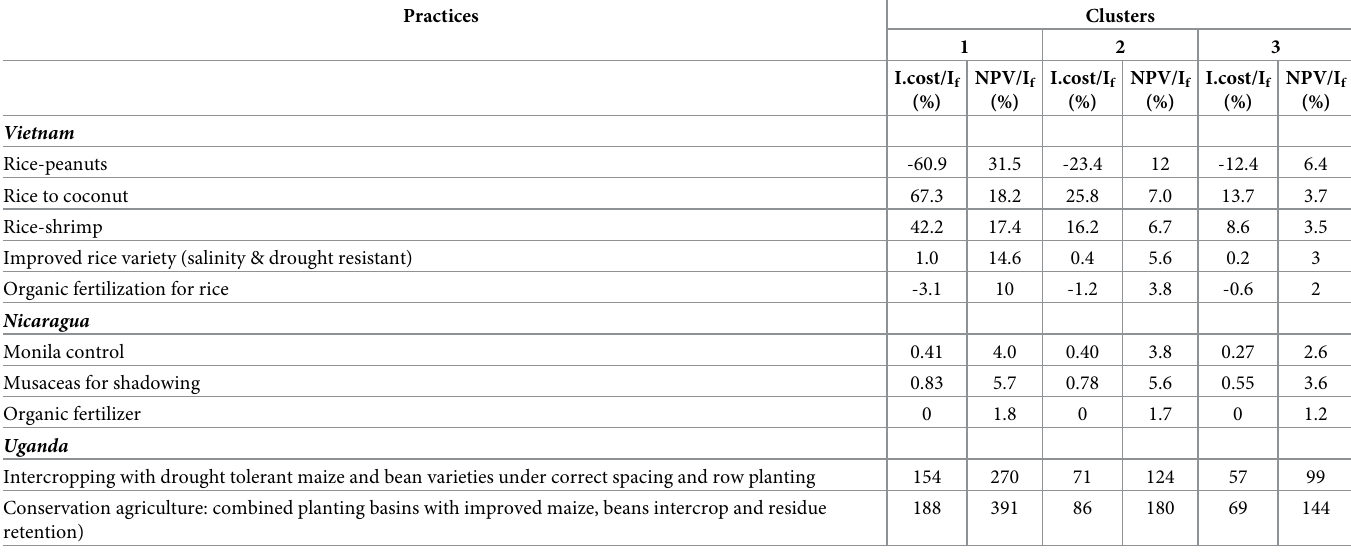
Table 6. NPV and Initial investment of CSA practices versus average income of